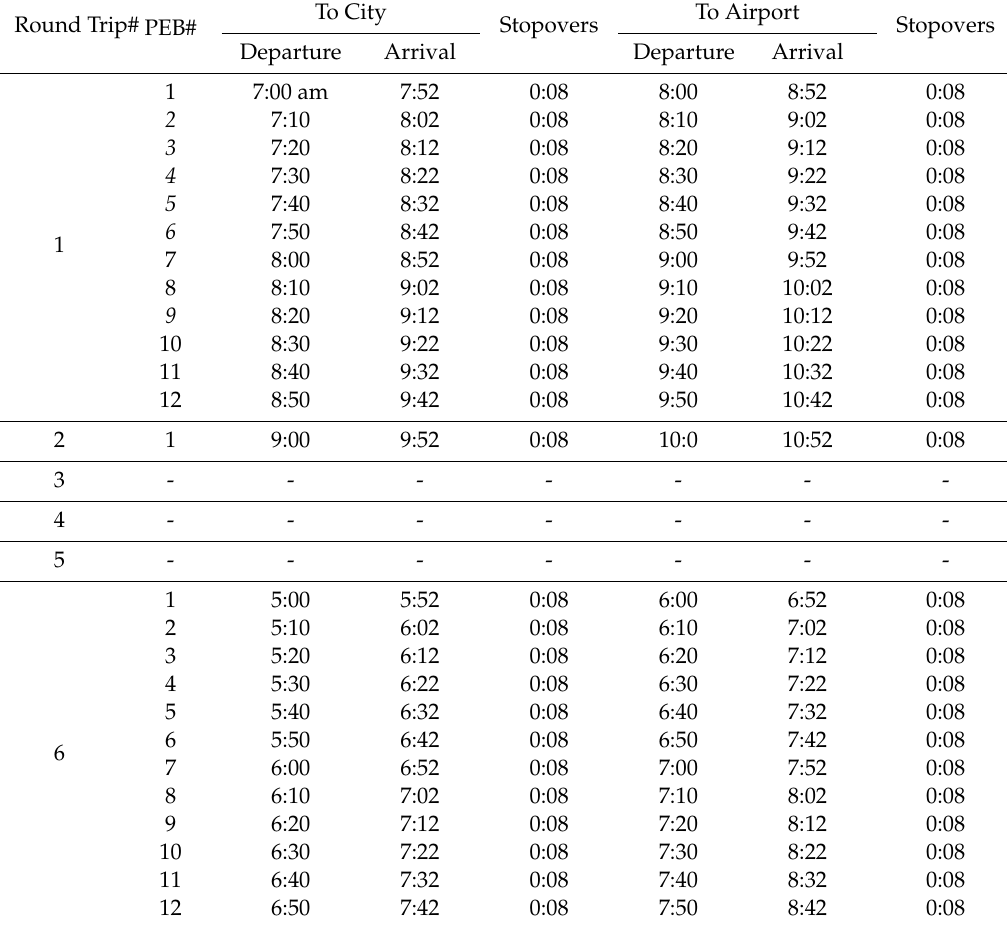
Table 2. Skybus arrival and departure schedule (airport to city only). Round Trip#